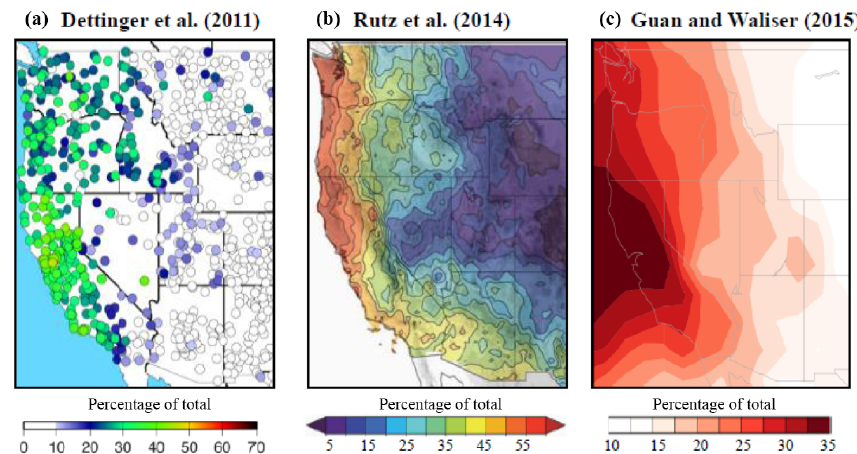
Figure 2. Examples of different algorithm results. (a, b) The fraction of total cool-season precipitation attributable to ARs from Dettinger et al. (2011) and Rutz et al. (2014). (c) As in panels (a, b) but for annual precipitation from Guan and Waliser (2015). These studies use different AR identification methods, as well as different atmospheric reanalyses and observed precipitation